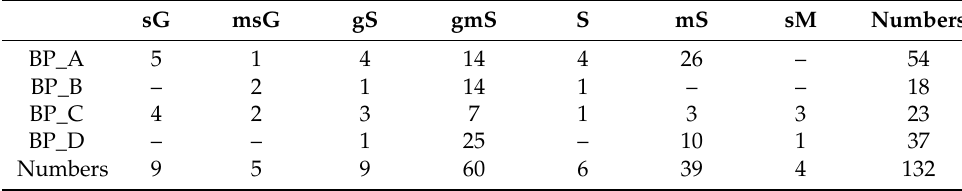
Table 2. The types and numbers of sediment samples in the four